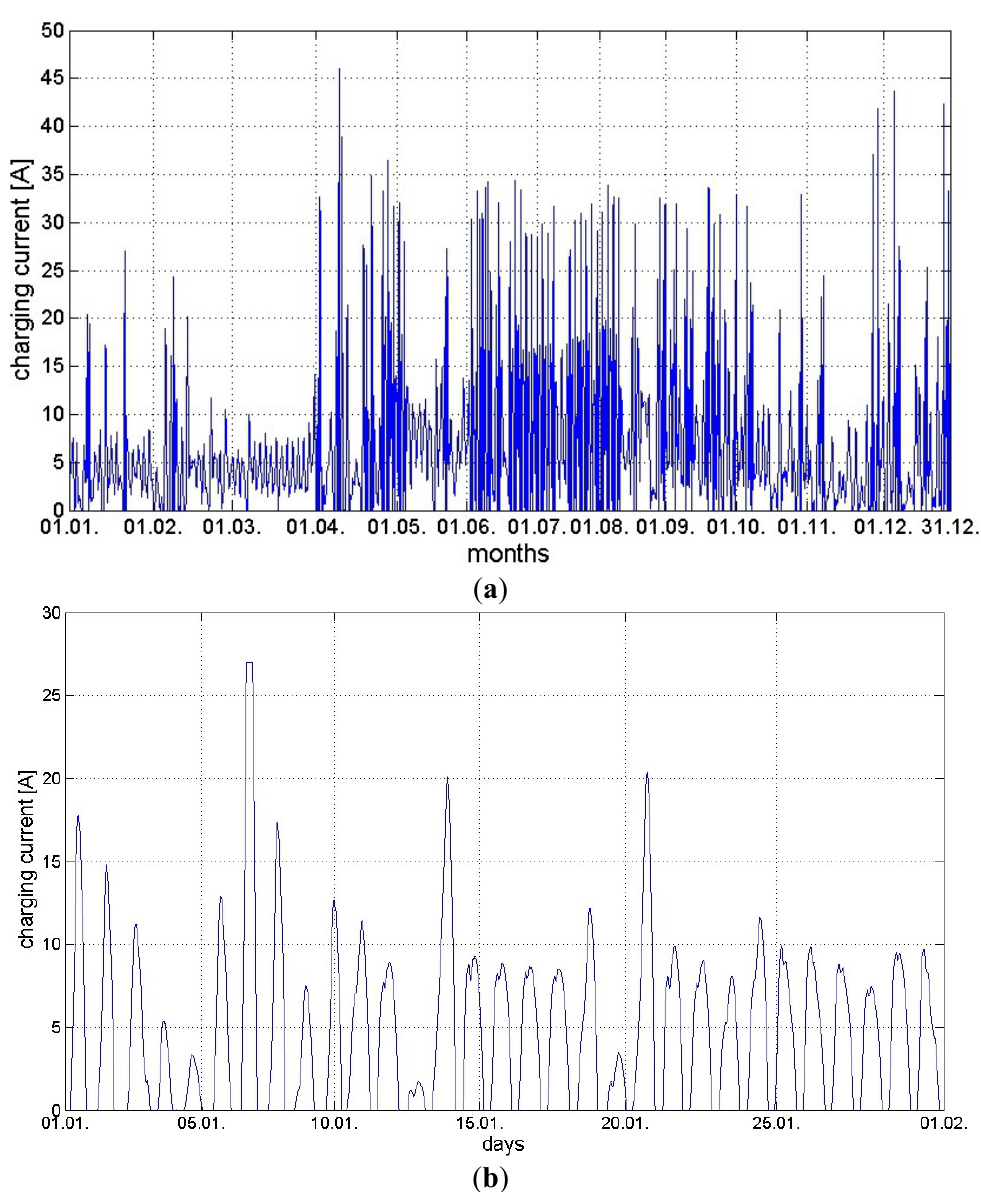
Figure 3. Variation of the charging current in the case of one solar array for the BSS A during: ( a ) a year; ( b )